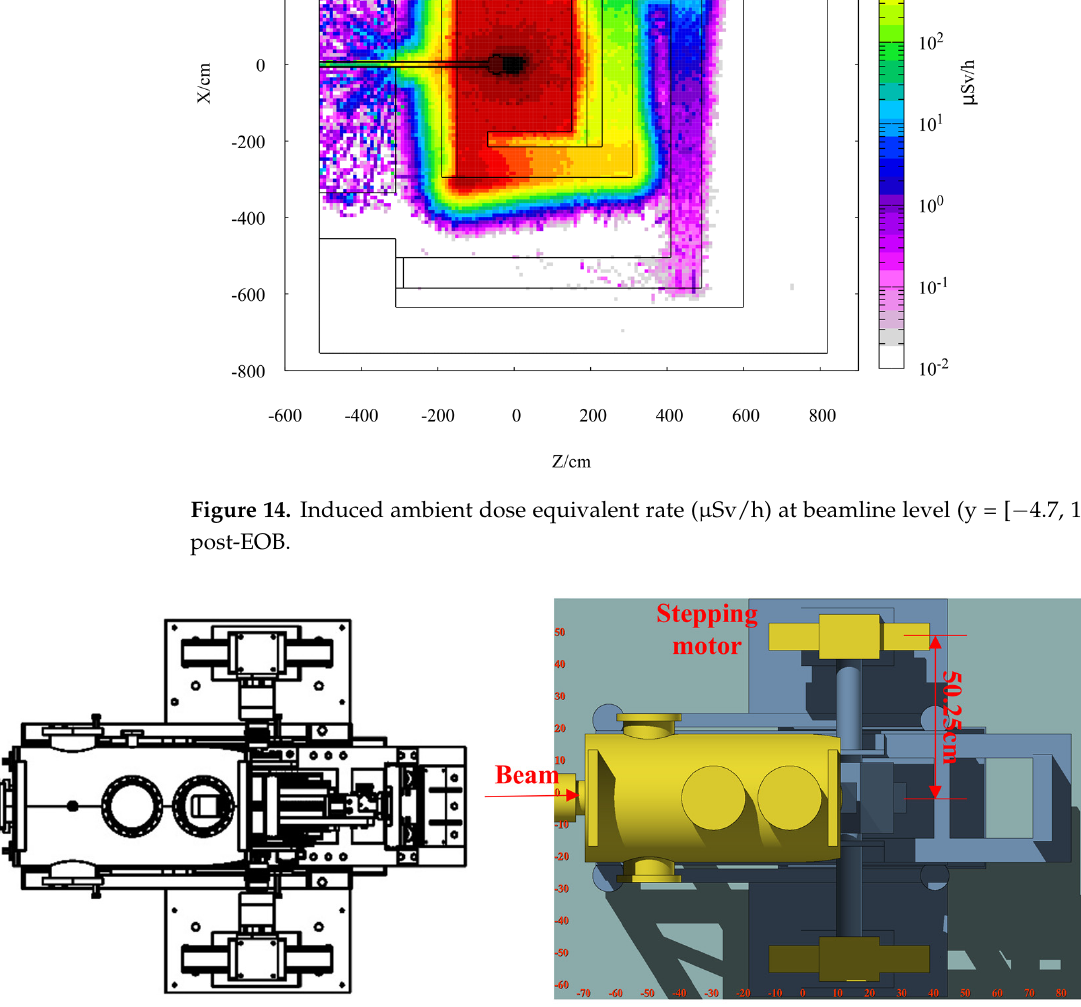
Figure 14. Induced ambient dose equivalent rate ( μ Sv/h) at beamline level (y = [ − 4.7, 1.6]) at 0 s post ‐ EOB.